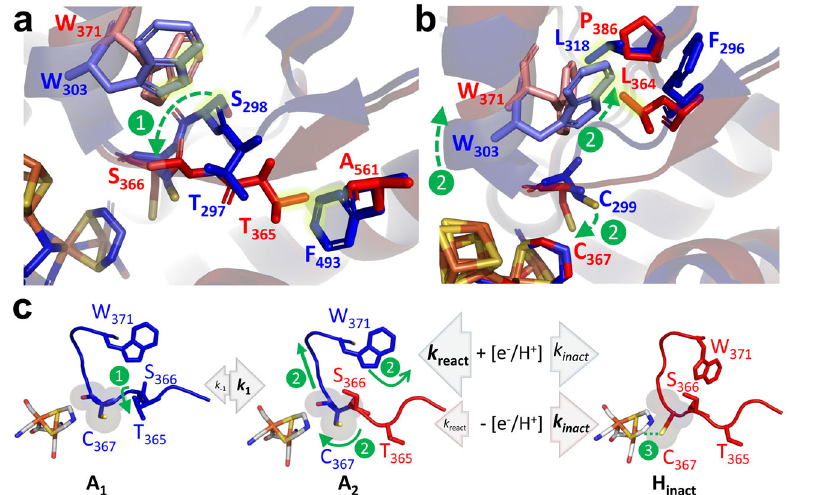
Fig. 5 Mechanism for the reversible formation of the O 2 -resistant H inact state in CbA5H WT . a , b Structural alignment of CpI (state A 1 , blue) and CbA5H air (H inact ; red) focusing on the TSC-loop. Residues labeled in red determine the structural rearrangement from A 1 to H inact . Corresponding CpI positions are shown in blue (yellow glow indicates clashes). c Illustration of the AAI mechanism. Main steps (1 – 3) in the transition from A 1 (blue) to H inact (red) via A 2 (blue-red) are marked in green, corresponding to structural rearrangements (1-3) shown in a-b. 1: Partial shift of the TSC-loop, including T365, initiating the A 1 to A 2 transition. 2: W371-translocation and α -helix uplift, dragging along C367 closer to Fe d (green arrows) 3: Binding of C367 to Fe d (dotted green line) and oxidation of the H-cluster yields the inactive but O 2 -resistant H inact state. Arrow and font sizes re fl ect relative rates of k 1 and k -1 or k inact and k react , in CbA5H, which de fi ne the dynamic equilibrium between A 1 , A 2 , and H inact . Under reductive conditions ( + e − /H + ) the k inact /k react ratio favors A 2 , whereas H inact accumulates under oxidative conditions ( − e − /H +